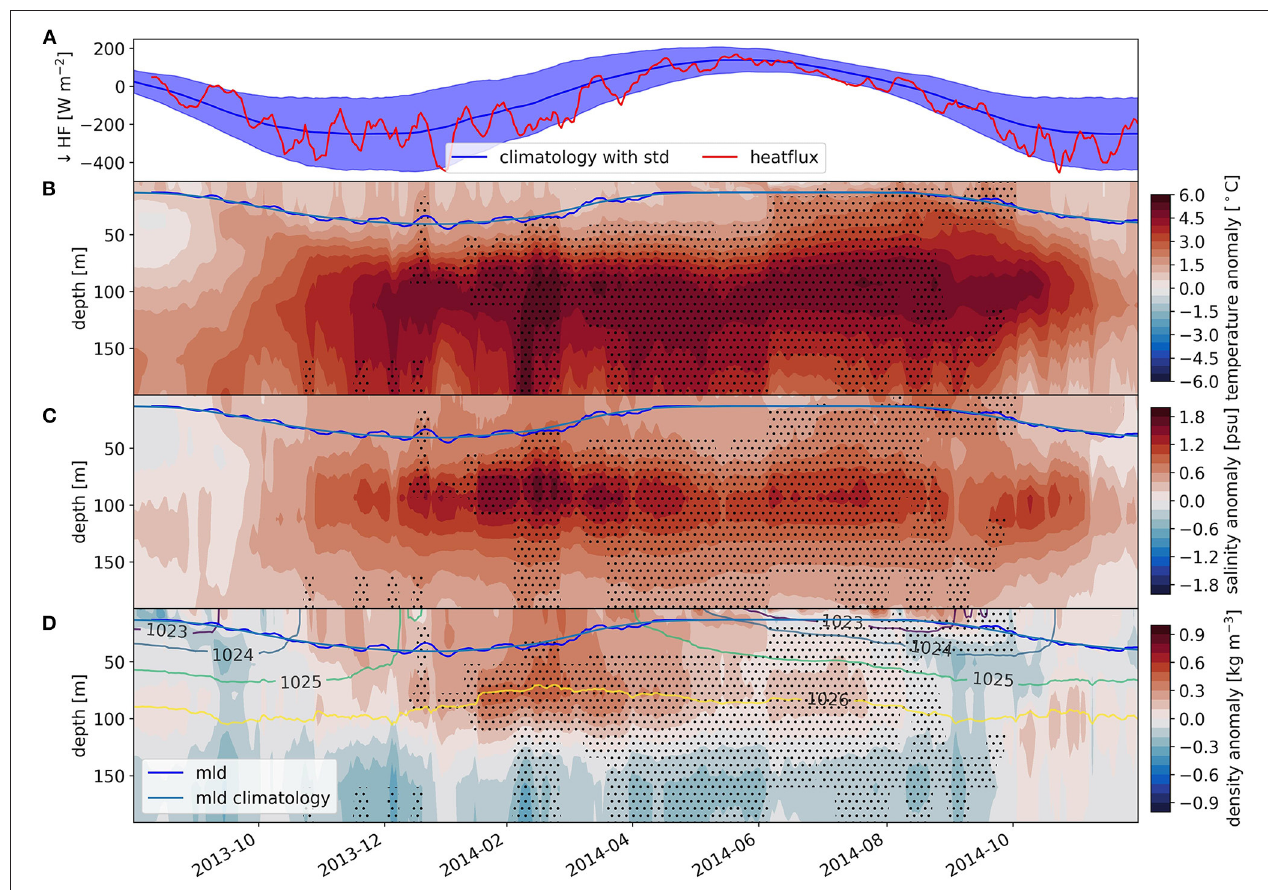
FIGURE 12 | 2014 MHW characteristics; time series of net downward surface heat flux (A) and hovmoeller plots for temperature (B) , salinity (C) , and density (D) anomalies with depth over time for 2014; (A) contains the heat flux from the current year and the heat flux climatological values; light and dark blue line (B–D) show mixed layer depth from climatology and in 2014; labeled contour lines in (D) show absolute densities, stippling indicates MHW state; 10 day rolling window for heatflux and mixed layer depth time series. Values displayed represent an average over the shelf (ecoboxes, see Figure 1